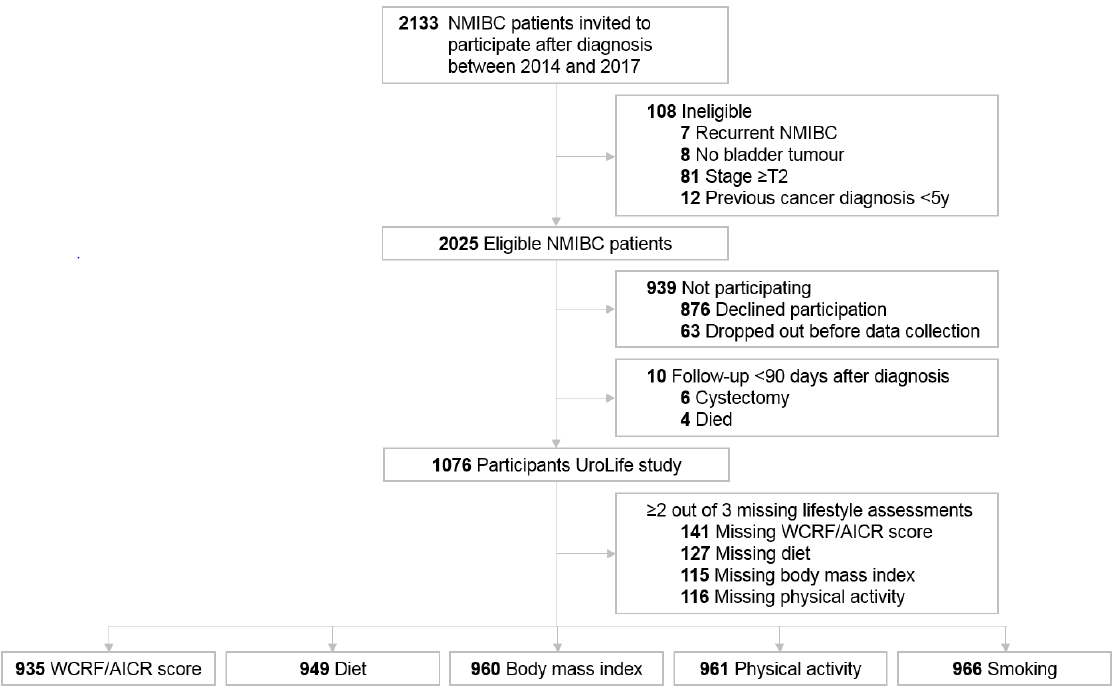
Figure 1. Flowchart of the study population in a longitudinal study among non-muscle invasive bladder cancer patients (NMIBC), the UroLife study.